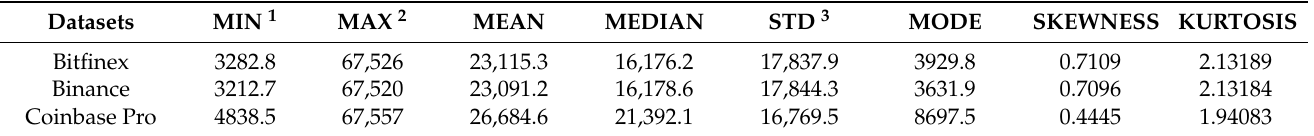
Table 2. Statistical Analysis of